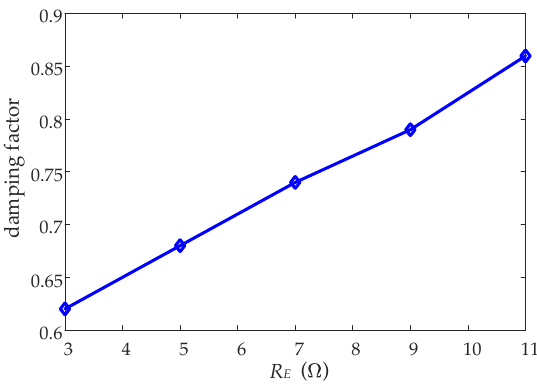
Figure 5. The simulated relationship between the damping factor and R E .